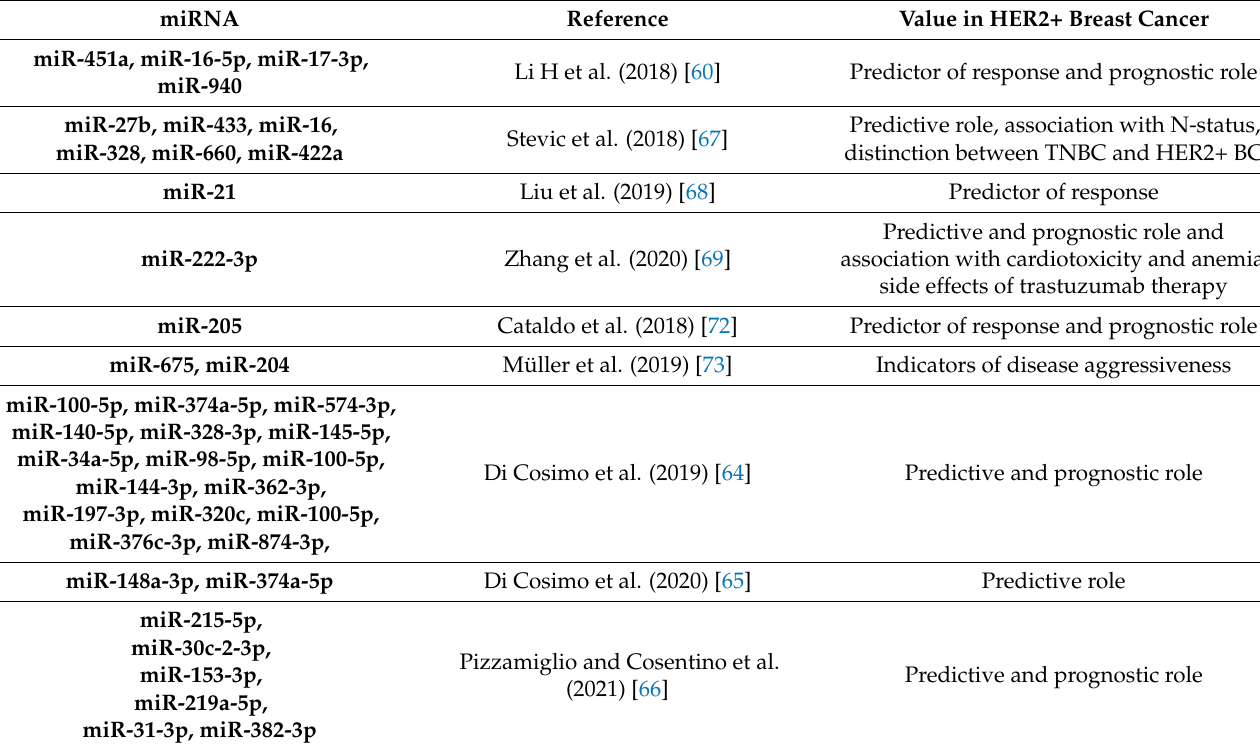
Table 2. miRNAs as biomarkers in HER2+ breast